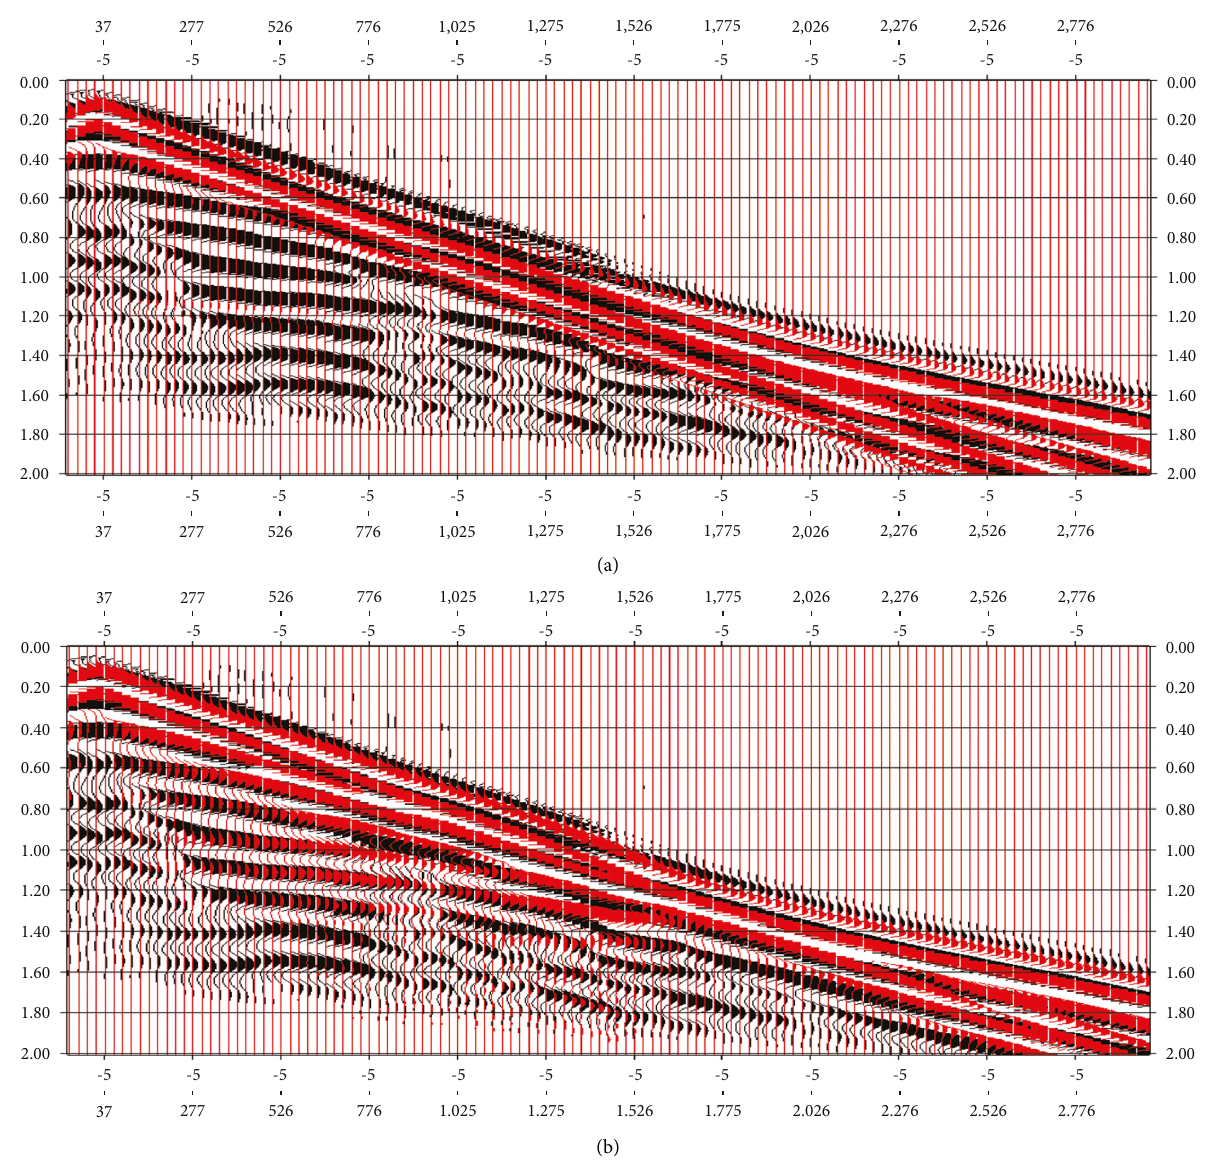
Figure 9: (a) Waveform fitting of early arrival between the synthetic data (red) and observed data (black) for the L2-norm EWI; (b) waveform fitting of early arrival between the synthetic data (red) and observed data (black) for the W2-norm